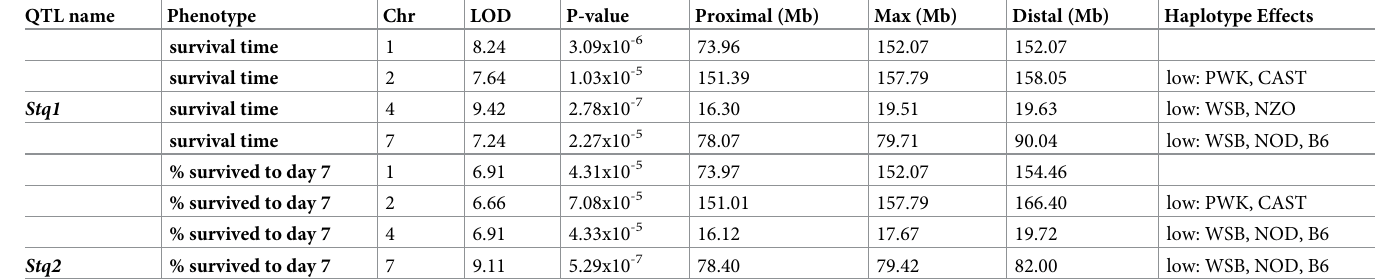
Table 1. QTL associations for median survival time and percent survived to day 7 after STm infections. 30 CC strains were included in the gQTL analysis, excluding CC042 and CC045.